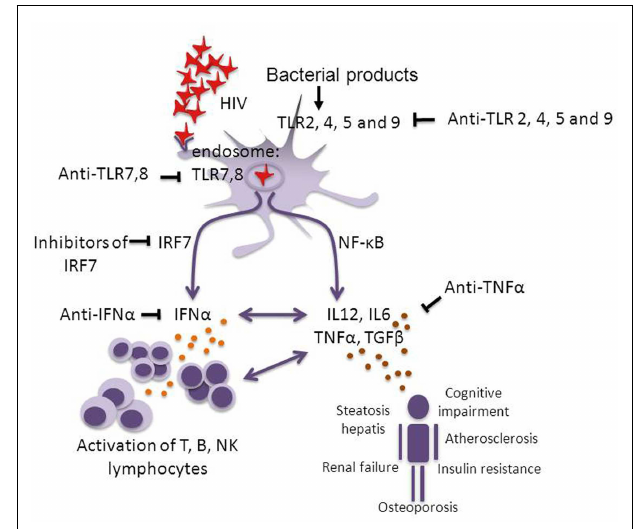
FIGURE 1 | Pathways of chronic immune activation and its down-stream effects in HIV infection . HIV infection induces chronic immune activation through activation of the innate and the adaptive immune system, via single-stranded (ss) RNA and possibly through intracellular viral DNA which activate pDCs via endosomalTLR7 and 8.This activation leads to the induction of IFN α via the IRF-7 pathway and the induction of IL-6, IL-12,TNF α , andTGF β through the NF- κ B pathway. Continuous activation of the lymphocyte compartment leads to attrition of theT-cell pool (14, 15) and “immune paralysis” (e.g., impaired CTL responses). Bacterial translocation may be another source ofTLR activation viaTLR2, 4, 5, and 9 (49–51). Over time also non-AIDS related complications develop. Potential targets for therapeutic interventions with inflammation to diminish pathology are indicated. It has been shown that blocking the effect ofTLR7 and 9 significantly reduces HIV-induced immune activation (124). Studies in pathogenic and non-pathogenic SIV infection suggest that blocking IRF-7 or IFN α should be investigated. In rheumatoid arthritis patients who were treated withTNF α inhibiting agents (infliximab, etanercept) it was shown that blocking the effect ofTNF α reversed the increased incidence of cardiovascular complications and insulin resistance. In analogy, the potential for a therapy interfering withTNF α in HIV infection should be tested